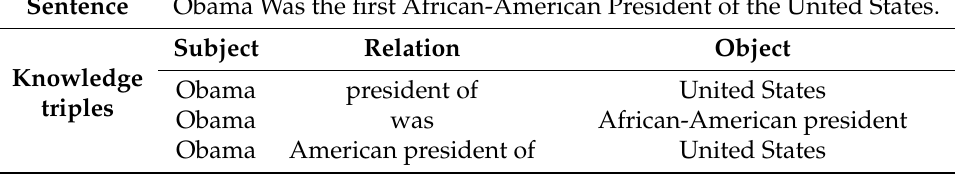
Table 1. Sample of knowledge triples extracted from the sentence using OpenIE.